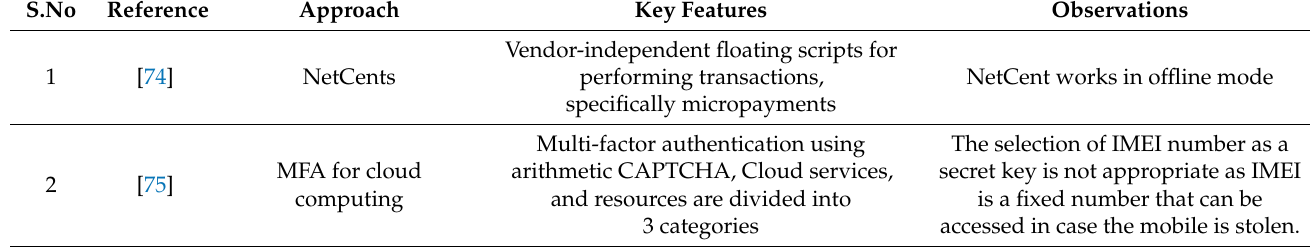
Table 2. Observation and Analysis of Related Research Works on